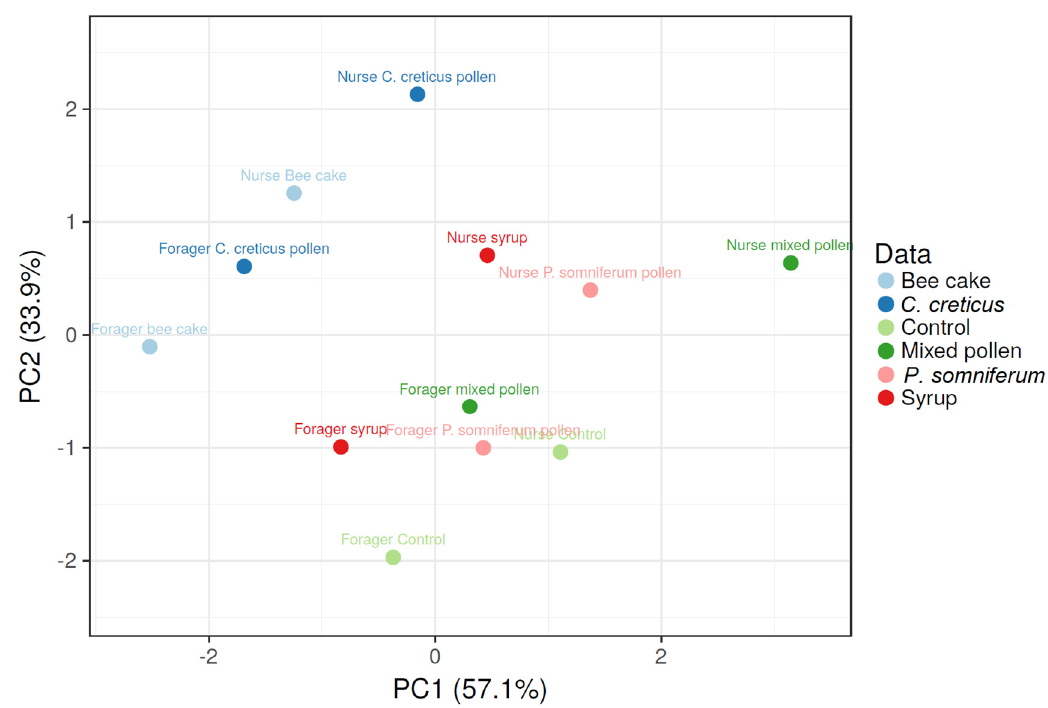
Figure 2. PCA was obtained according to Vg values of forager and nurse bees before feeding and after in late fall and early spring. The first two components explained 91% of the data variance. The variables with loading values close to zero present a similar pattern in the forager or nurse bees.